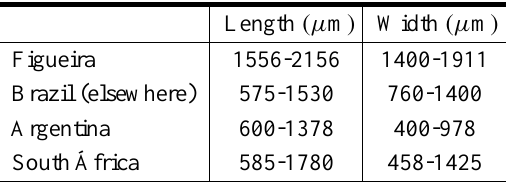
Comparison between dimensions of Sublagenic- ula brasiliensis from the literature and from Figueira.